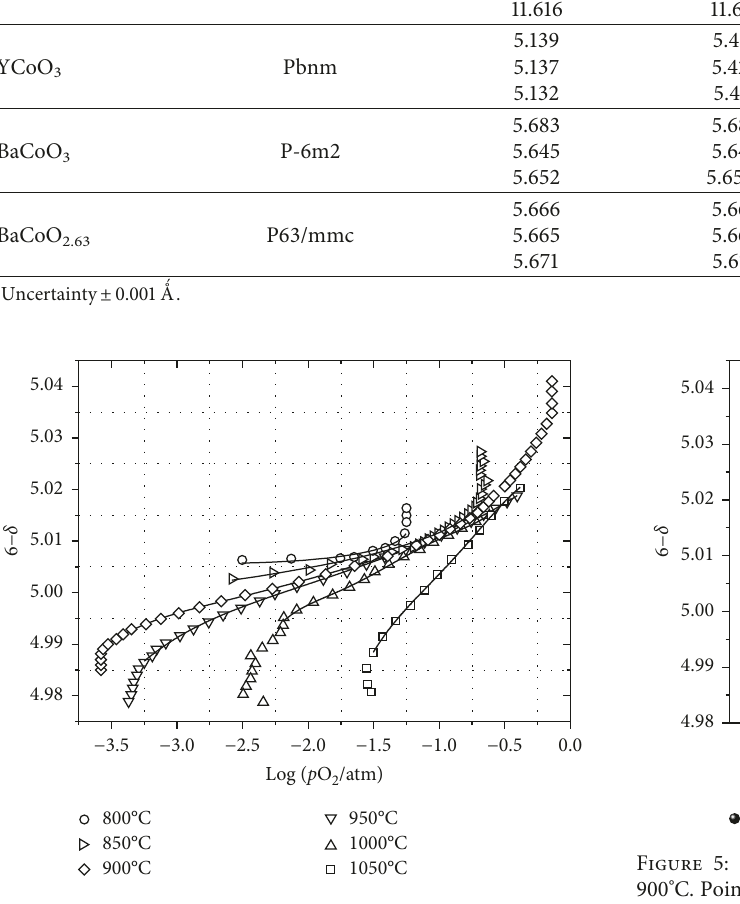
Figure 4: Oxygen content, 6 different temperatures. Points correspond to experimental data and lines are guide to eye only.